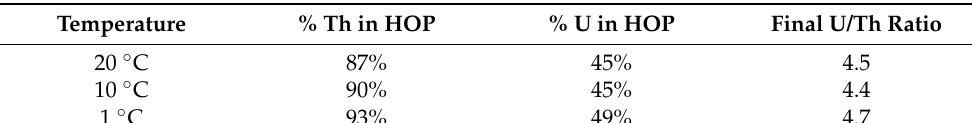
Table 3. Outcome of organic phase splitting upon cooling to a give temperature of an organic phase prepared by contacting a 1 M TBP solution in n -dodecane to an aqueous 6 M HNO 3 solution containing U(VI) and Th(IV) at 70 ◦ C. Initial (U) = 395 mM and initial (Th) = 45 mM (U/Th ratio equal to 8.8) at 70 ◦ C.